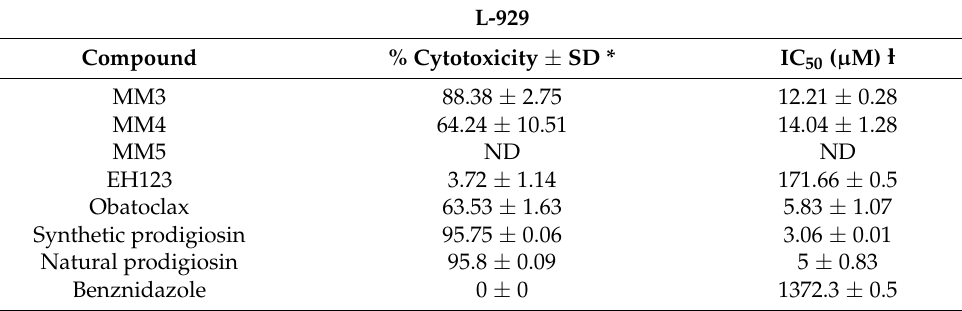
MM3, MM4, MM5, and EH123 are tambjamines; L-929, murine L-929 fibroblasts (NCTC clone 929); SD, standard deviation; ND, not determined. * The results are expressed as the mean of the cytotoxicity values (% cell growth inhibition) at the concentration of 16 µ M ± SD (n = 9) using data obtained in triplicate runs from three independent experiments. MM3, MM4, MM5, and EH123 are all tambjamines. ƚ Results are expressed as the mean IC 50 value for each compound (± standard deviation) using data obtained in triplicate runs from three inde- pendent experiments. The IC 50 value is the concentration that causes 50% of growth inhibition. Table 2. Biological activity of tambjamines, Obatoclax, synthetic and natural prodigiosins, and benznidazole against trypomastigotes/amastigotes of T. cruzi (CLB strain) at the highest concentra- tion assayed (16 µM).